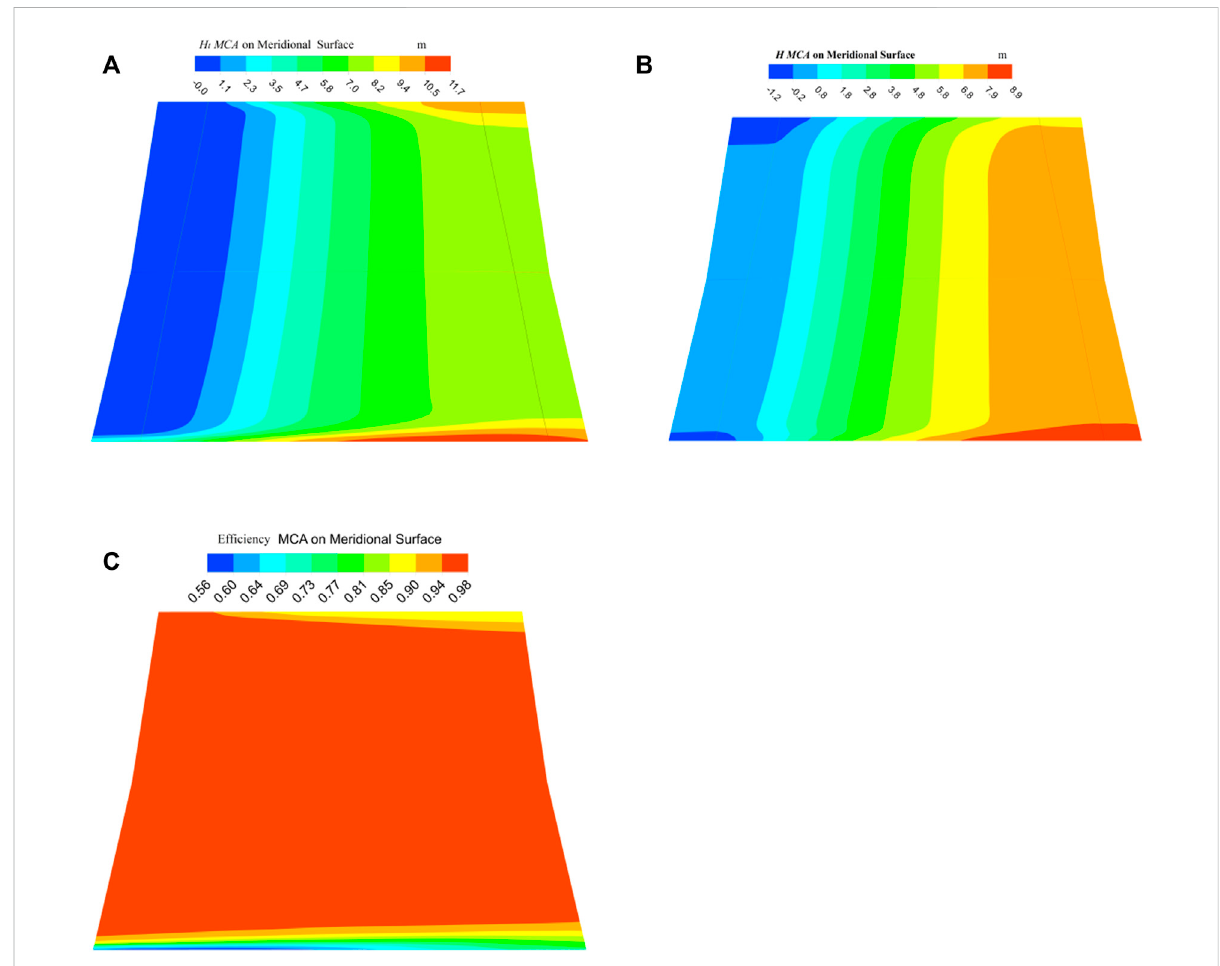
FIGURE 13 Thecontouroftheweightedaverageoftheheadandef fi ciencycoef fi cientsbasedonmass fl ow: (A) Thetheoreticalhead; (B) Thehead; (C) The ef fi